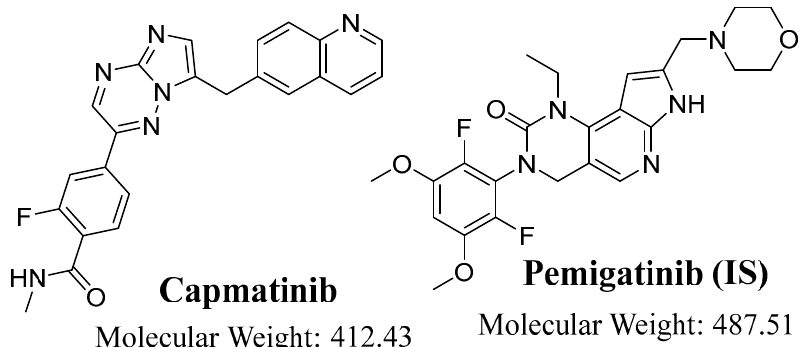
Figure 1. Chemical structure of capmatinib and pemigatinib (IS).